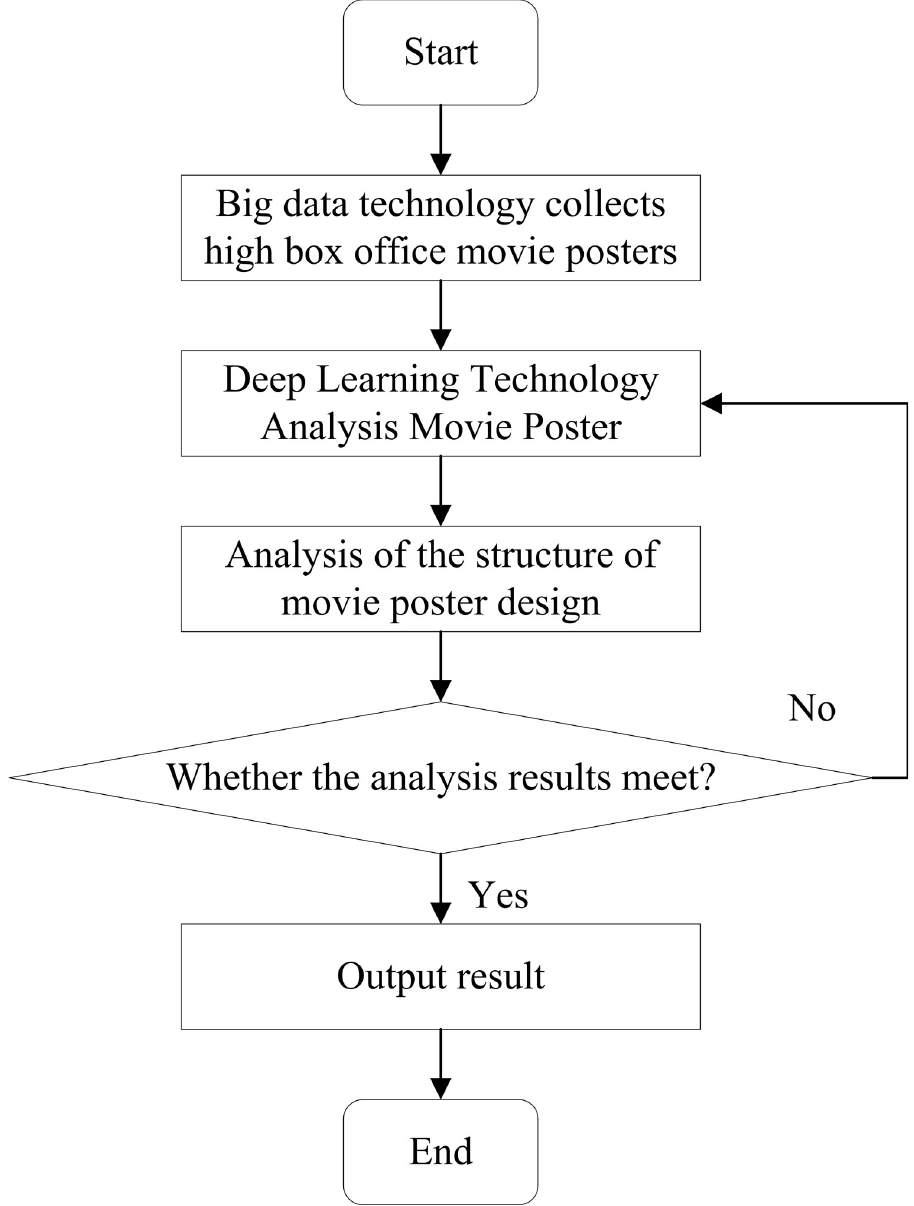
Fig 4. The model calculation